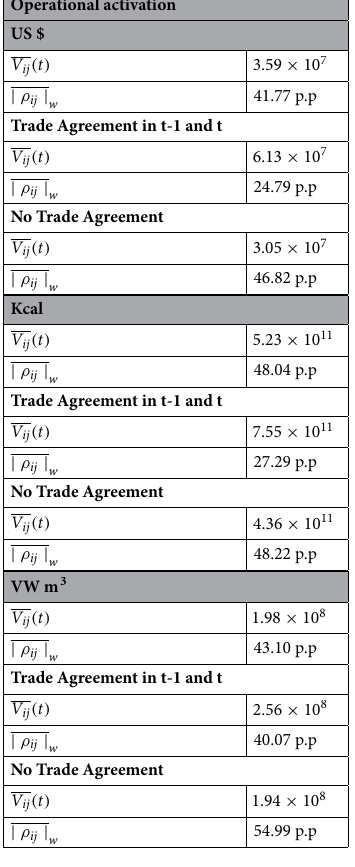
Table 2. Average values of trade flows and flow variation index ρ ij for each of the three sets, in US$ (a), Kcal (b), and Virtual water (VW, m 3 ). The bar indicates the average operator. The subscript w indicates the weighted average, where weights correspond to the flows at time t − 1 (i.e., V ij ( t − 1 ) ). Values of ρ ij is reported in percentage point (p.p). Section (d) of the supplementary material provides the values of virtual water separated into the blue and green water components.